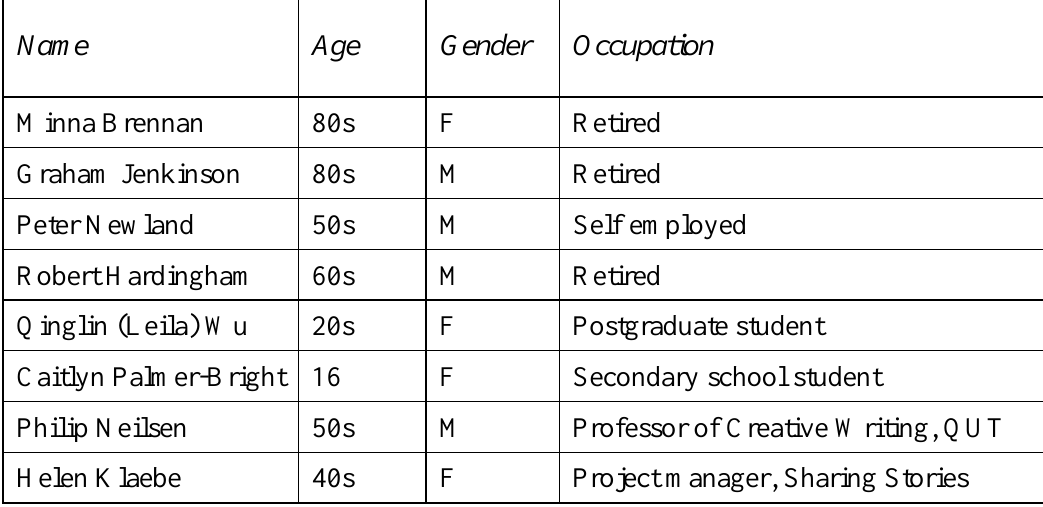
Table 3: Participants at first KGUV Sharing Stories